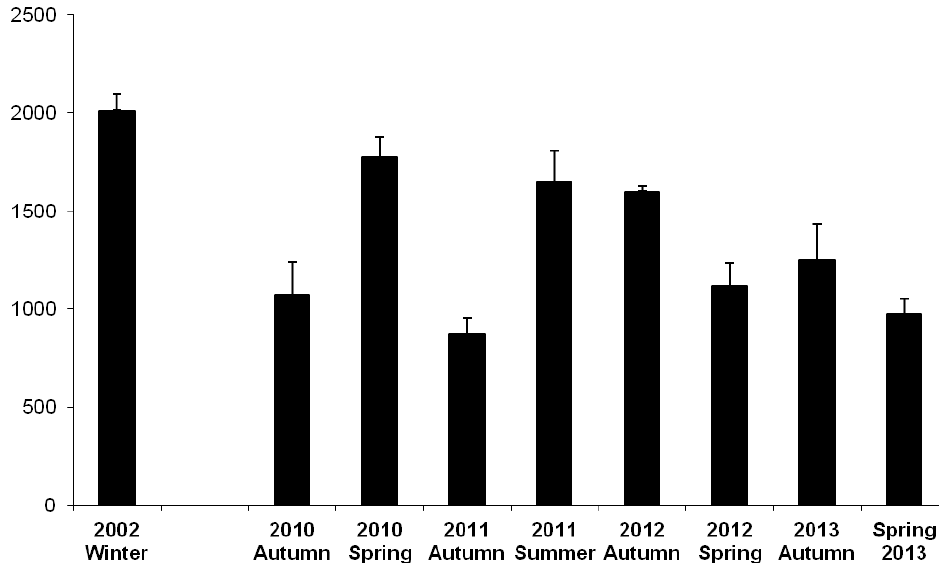
Figure 1. Content (±SD) of LC omega-3 oils (EPA + DPA + DHA, mg/100 g) in farmed Tasmanian Atlantic salmon sampled in 2002 [10] and 2010–2013.